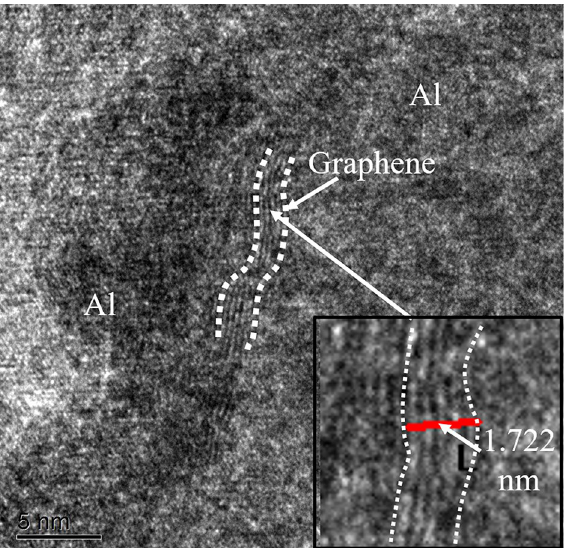
Figure 5. The high-resolution transmission of graphene in this material.